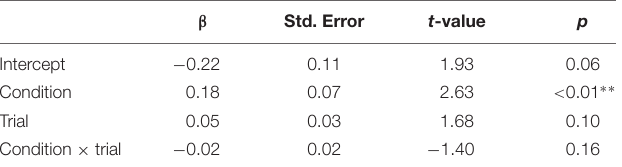
TABLE 1 | Fixed effects of condition, trial, and condition × trial on pupil dilation.